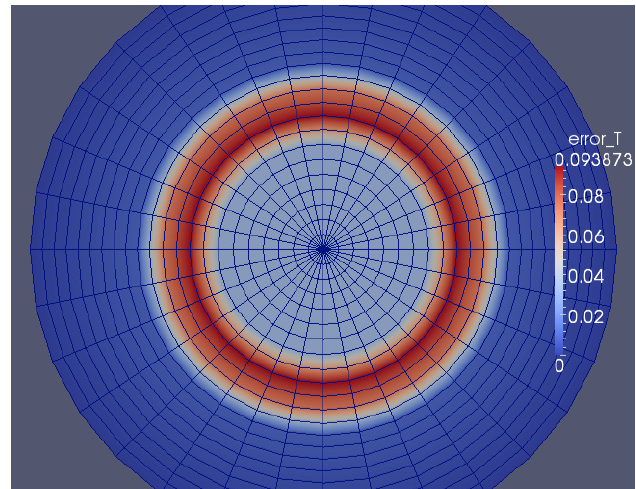
Fig. 7. Error distribution with orthogonal rectangular mesh in C norm.